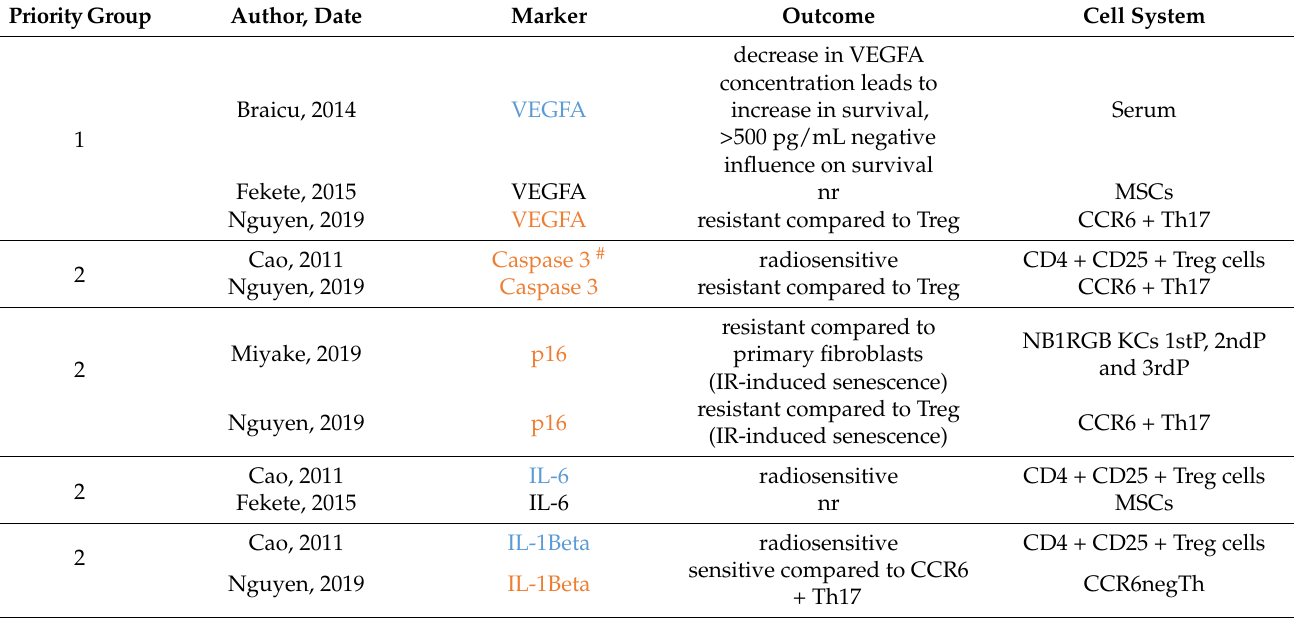
Table 3. List of proteins identified in at least two studies, not concerning repair